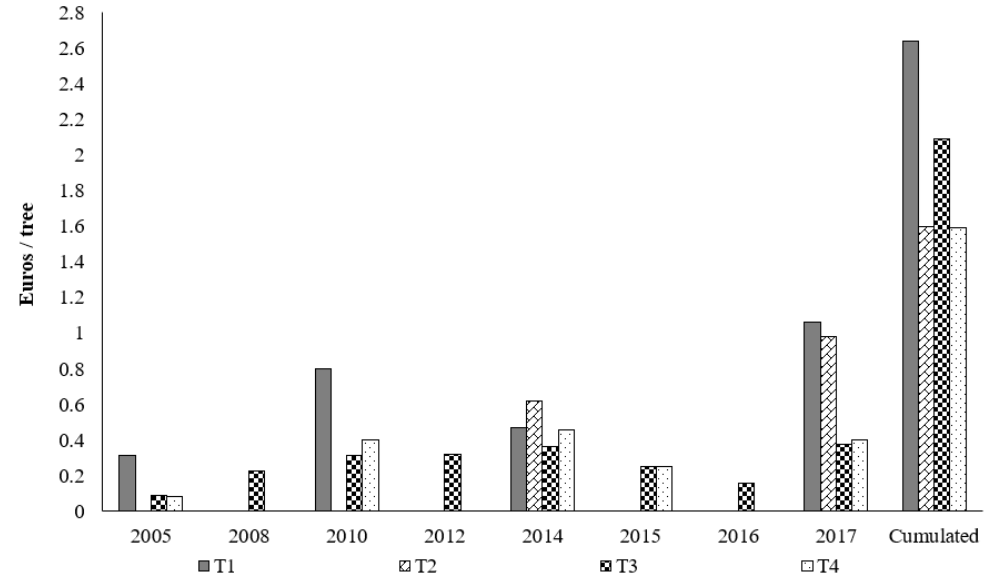
Figure 5. Pruning costs per treatment: T1—treatment 1; T2—treatment 2; T3—treatment 3; T4—treatment 4.